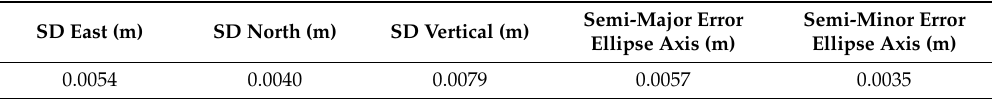
Table 2. Accuracy of the first Global Navigation Satellite System (GNSS) survey expressed in terms of standard deviation averaged over 30 benchmarks.